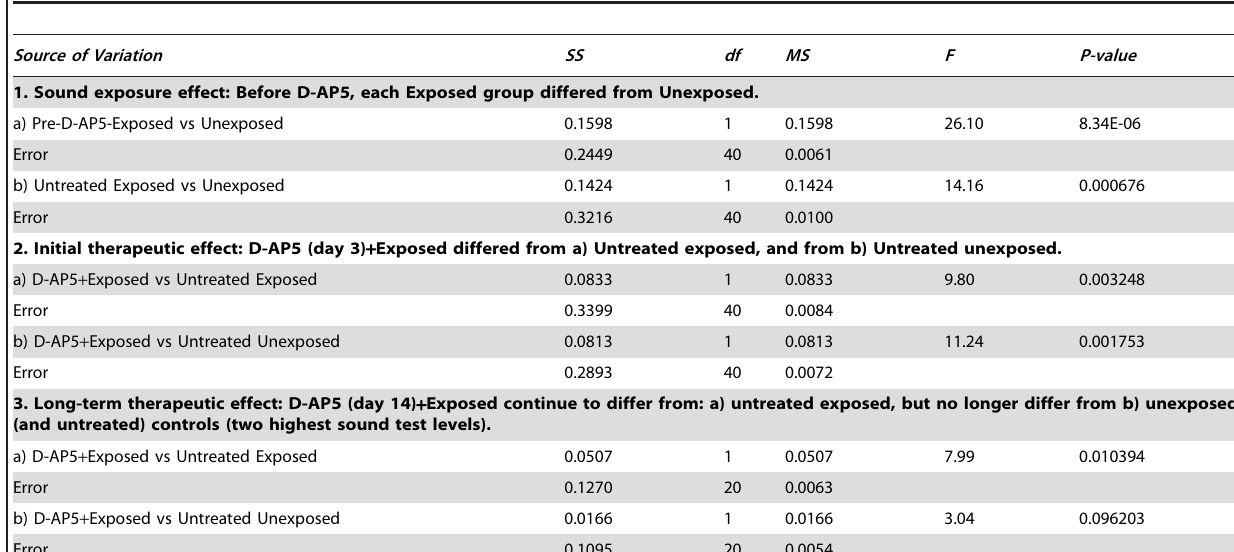
Table 1. Anova summary of psychophysical data (20 kHz diagnostic